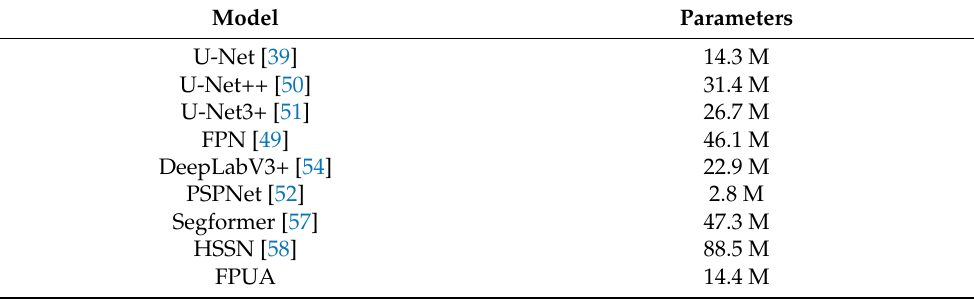
Table 2. Comparison of different architectures implementation.